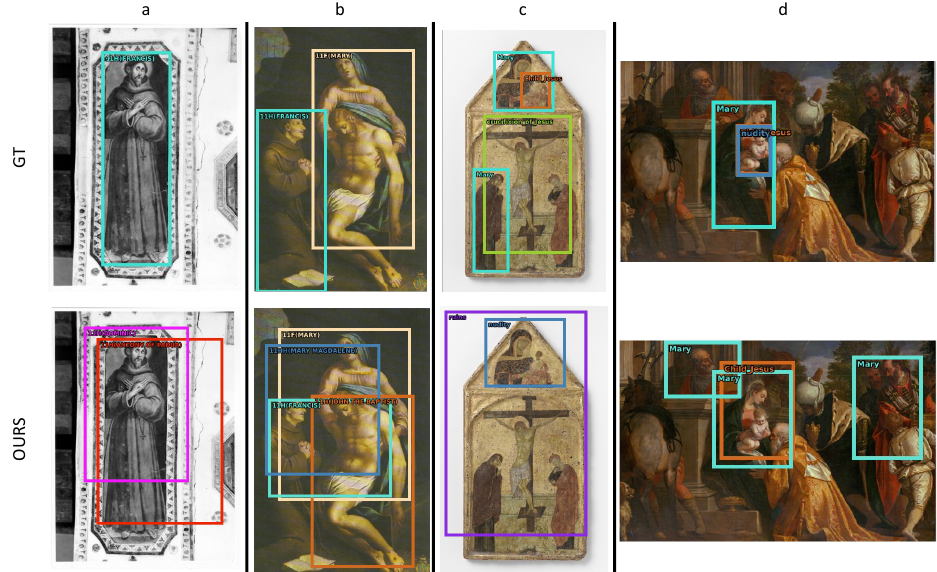
Figure 5. Negative WSOD detections —This figure presents negative examples on ( a – d ) four art- works from the ArtDL 2.0 and IconArt data sets. The first row contains the manually annotated ground truth and the second row shows detections from the proposed WSOD method. Bounding boxes are color-coded by class for better